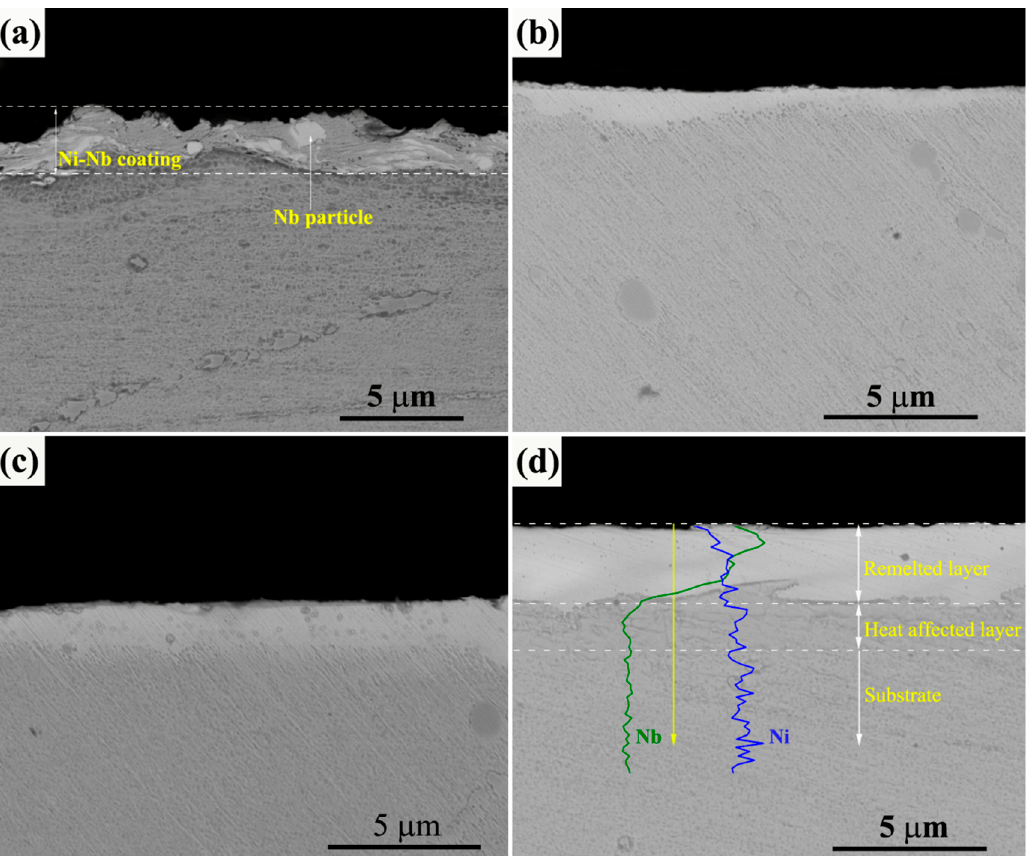
Figure 2. The cross-section BSE images of initial and irradiated Ni-Nb coating. ( a ) Initial samples; ( b ) 10 pulses; ( c ) 20 pulses; ( d ) 30 pulses.